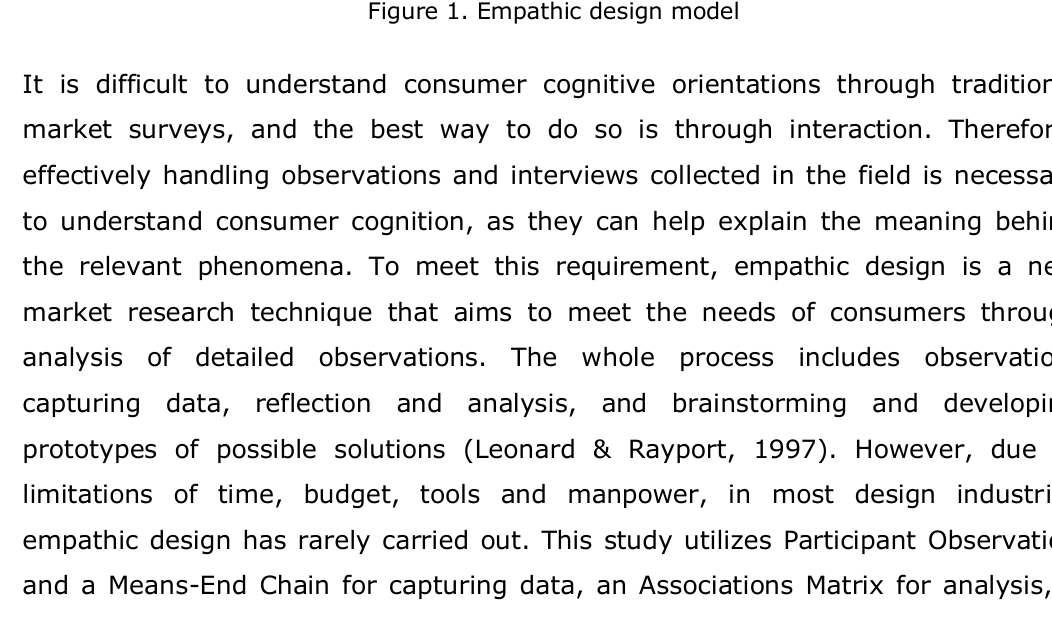
Figure 1. Empathic design